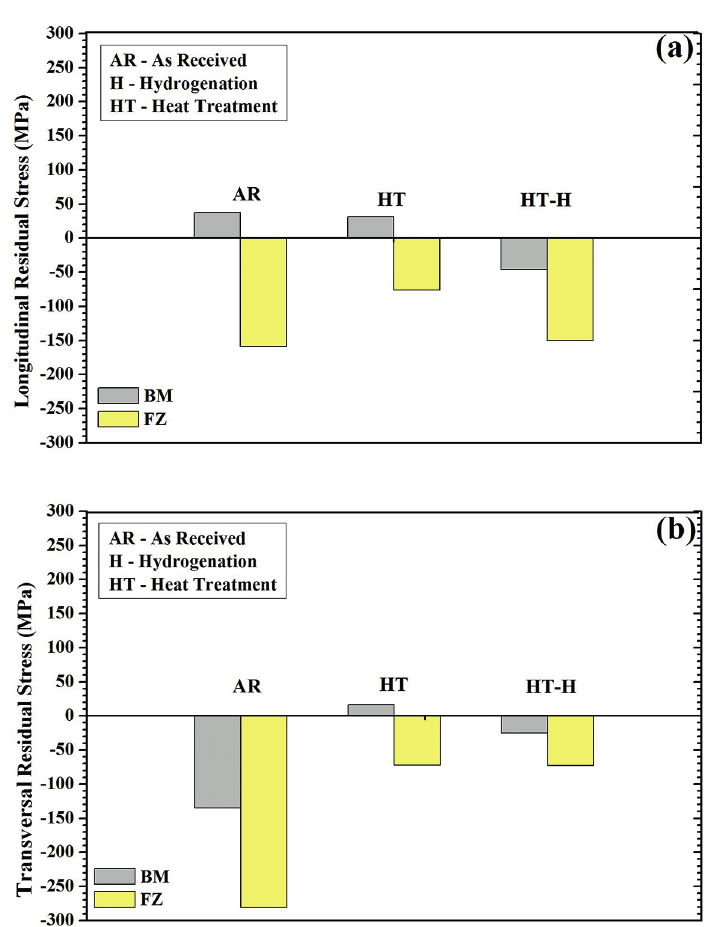
Figure 5: Residual stresses in Charpy specimens of BM and FZ in the Condition 3: (a) longitudinal residual stress; (b) transversal residual stress. stress of BM specimen presents a small value, close